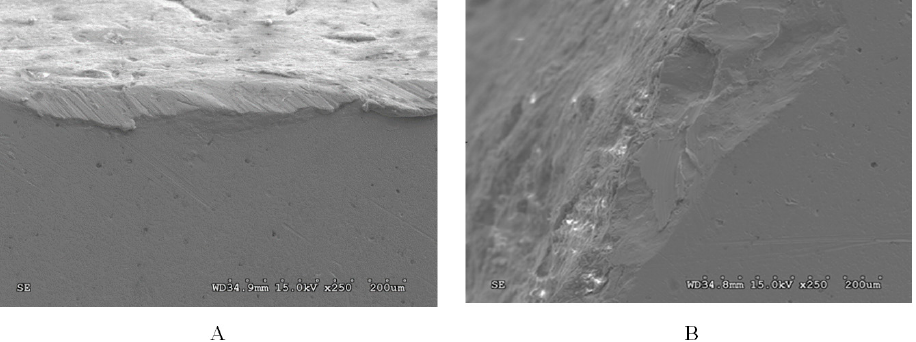
Figure 9. Surface micro-cutting marks ( A ) and deformations ( B ) of the sprocket made of the L35GSM steel cast, caused by quartz abrasive grains, SEM.